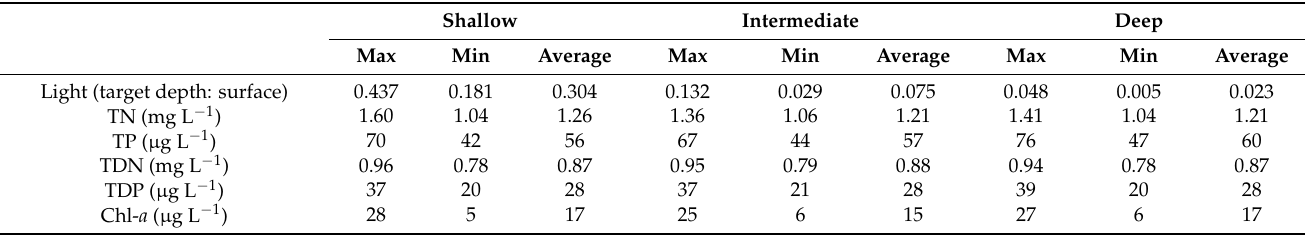
Table 1. Changes in light (light intensity of target depth to water surface), total nitrogen (TN), total phosphorus (TP), total dissolved nitrogen (TDN), total dissolved phosphorus (TDP), and chlorophyll a (Chl- a ) concentrations during the experiment.